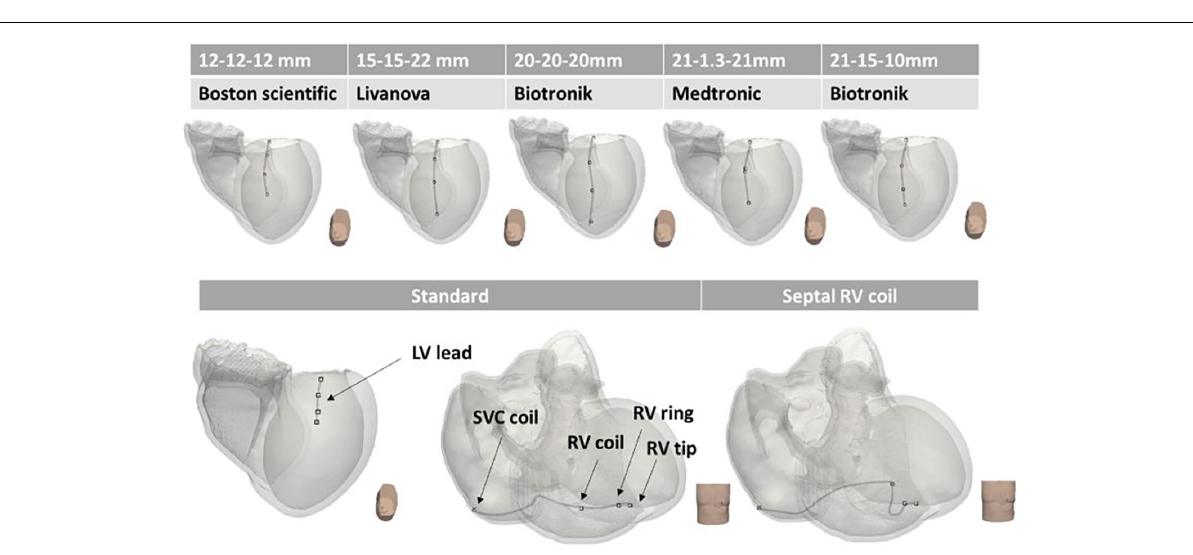
Frontiers in Physiology |